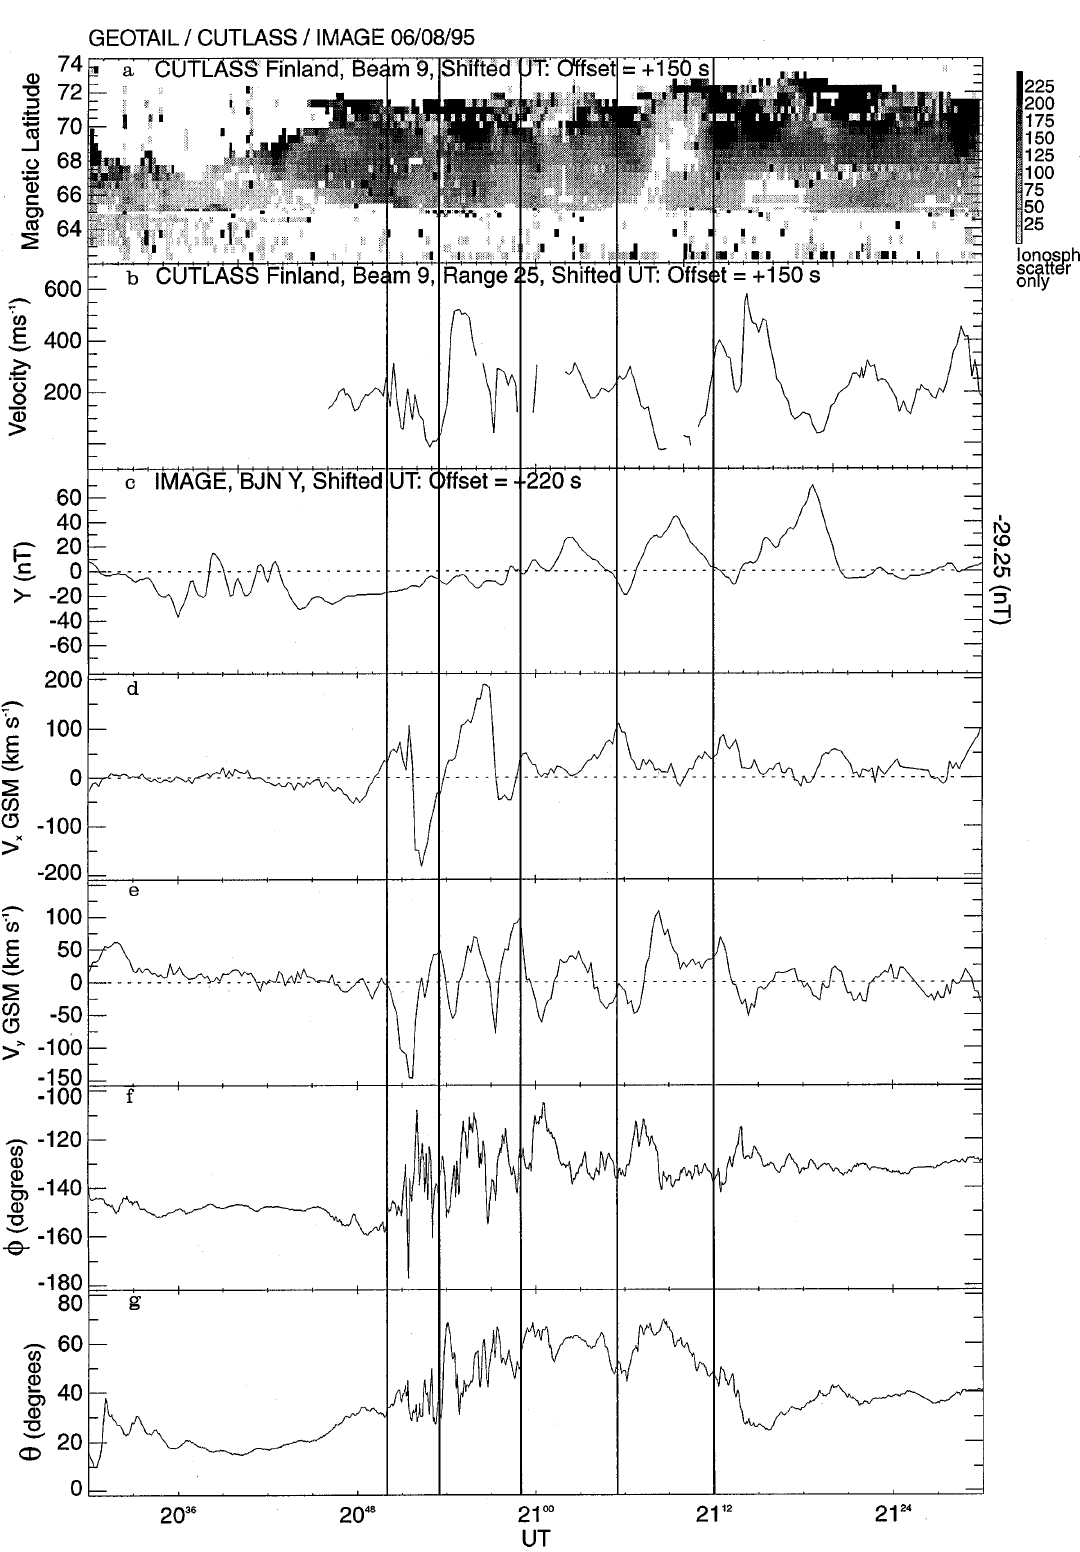
magnetic field measured at BJN. d and e display the GSM V ion velocity measurements. f and g represent the magnetic field orientation angles. In f , (cid:47) is the angle in the GSM X-Y plane, where ) 180 (cid:176) indicates a field pointing in the -X direction and ) 90 (cid:176) the -Y direction. g displays the field angle from the GSM equatorial plane,